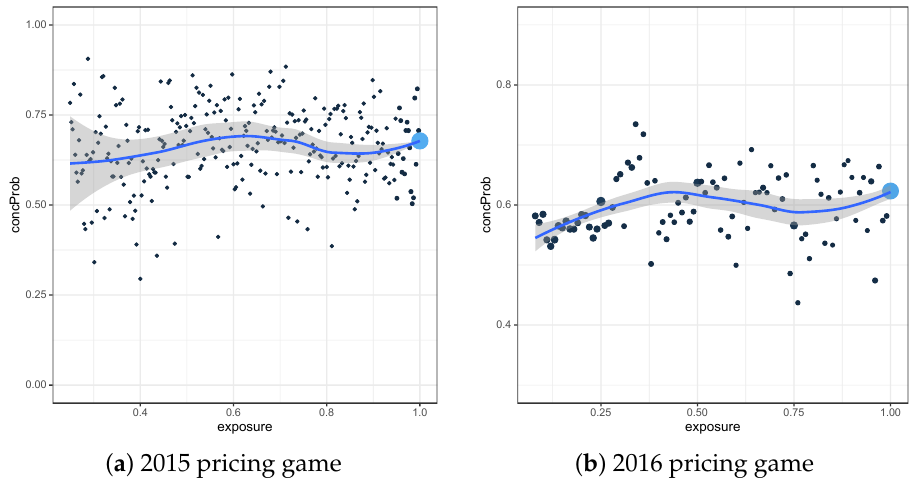
( λ ,0.05 ) , constructed as the weighted mean of the fine grid 0,1 +